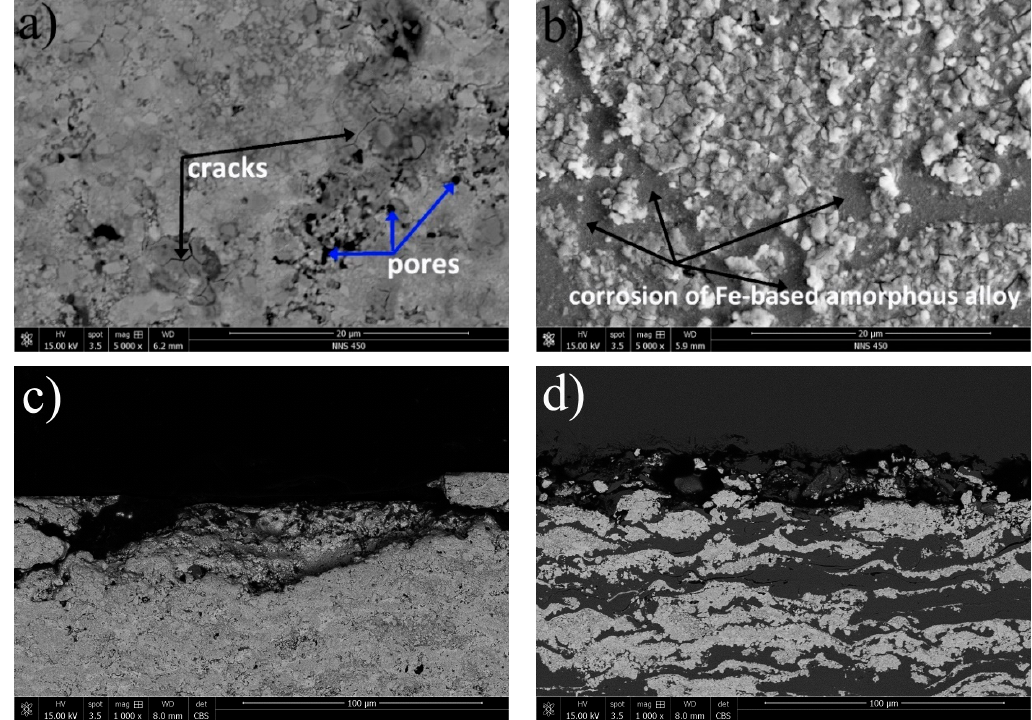
Figure 11. Surface and cross-section morphologies of ( a , c ) WC–CoCr coating and ( b , d ) composite coating after potentiodynamic polarization test in 1 M HCl solution.